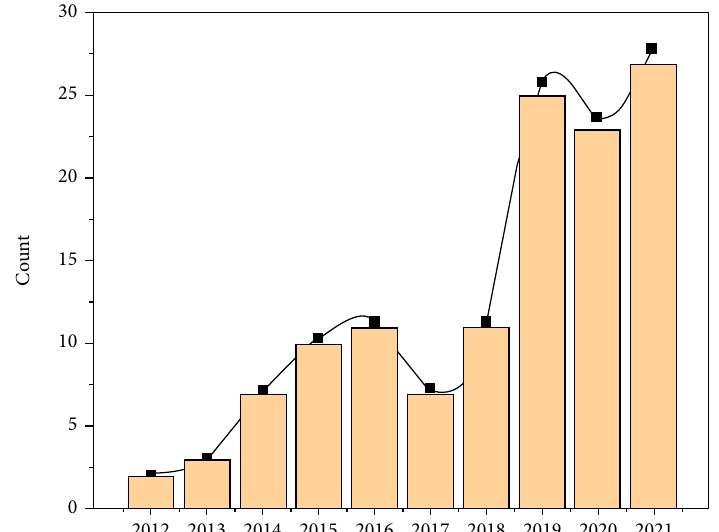
Figure 1: PI-based material for separator application.